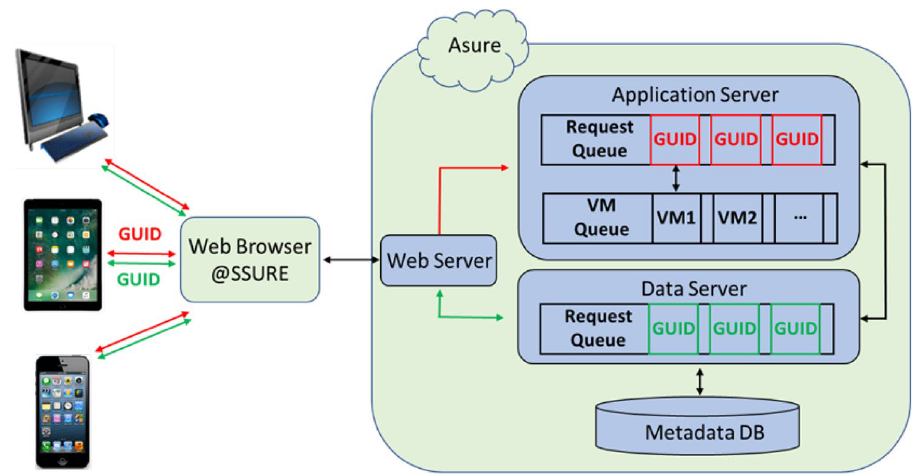
Fig. 3 Development of the web application in Azure. GUID stands for globally unique identifier. Red and blue GUIDs are analysis and data transmis- sion requests, respectively. The application server handles all analysis requests. The data application sever processes all data transmission requests. The web server is a bridge that com- municates between users and the other